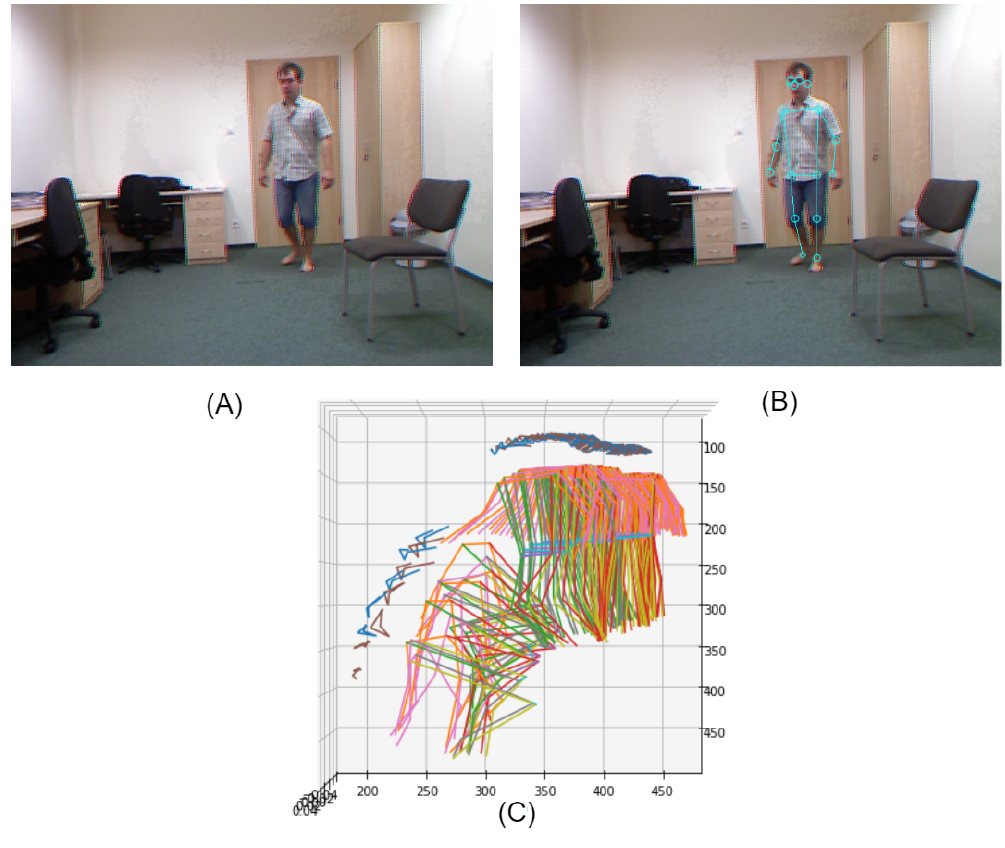
Figure 2. Results of applying the V2V-PoseNet model to detect the skeleton of a person: ( A ) the input frame to V2V-PoseNet; ( B ) projection into the input image of the skeleton detected by V2V-PoseNet; and ( C ) the 3D projection of a sequence of skeletons corresponding to a video